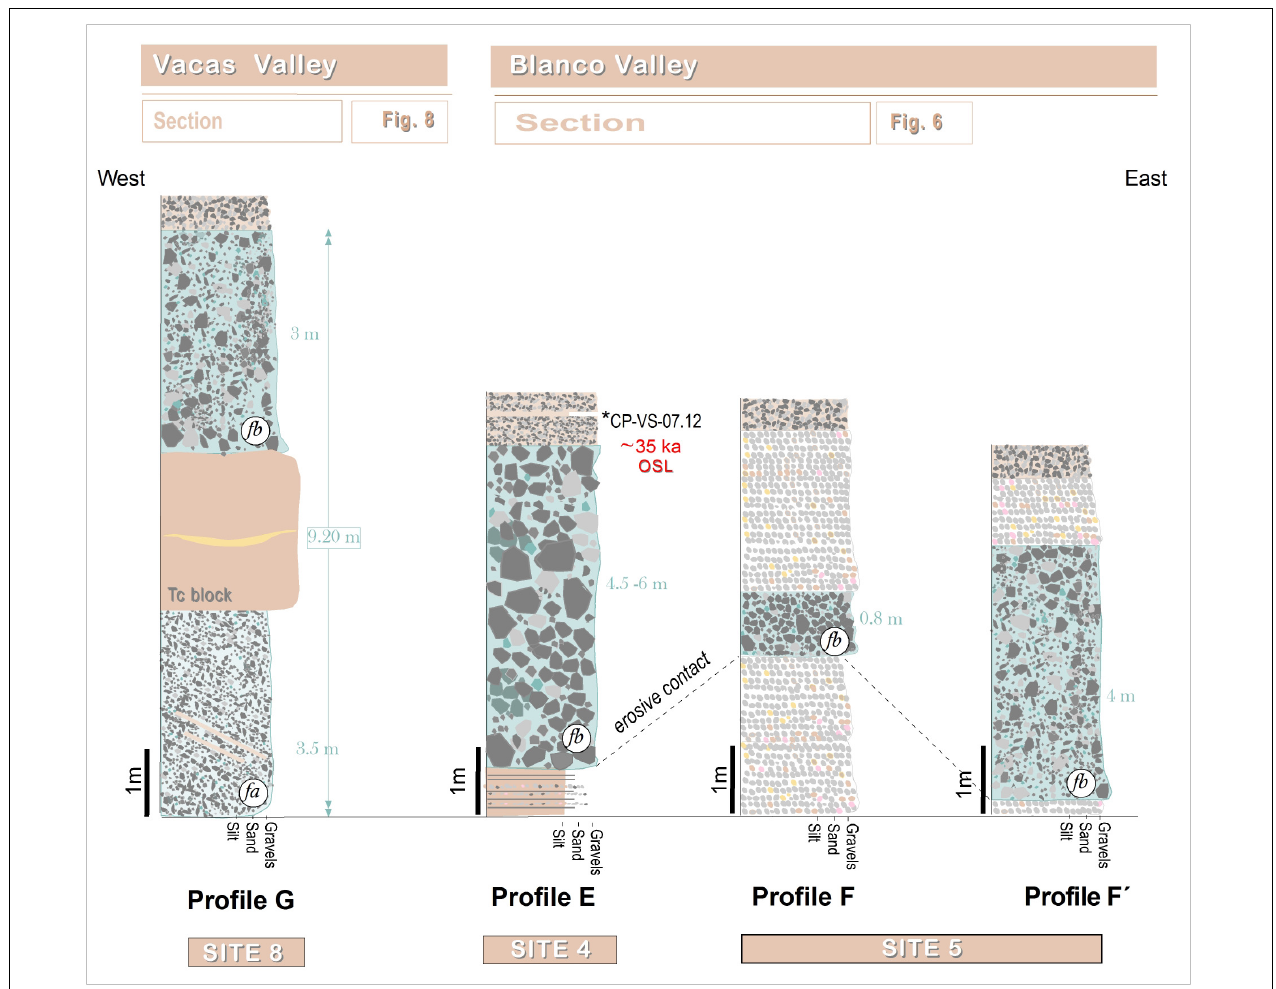
FIGURE 7 | Graph of sedimentological profiles described in sites 4 and 5 along the Blanco Valley (see pictures in the Figure 6 ) and profile G described in site 8 along the Vacas valley (see Figure 8 ). Tc block corresponds to the block of Tertiary rocks engulfing by the facie a (fa) and covered by the facie b